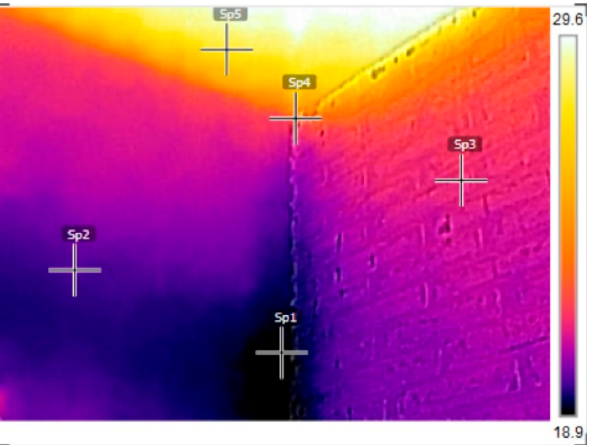
Figure 2. Thermal analysis of the building envelope using FLIR C3-X Compact Thermal Camera. Table 2. Passivhaus standard criteria.